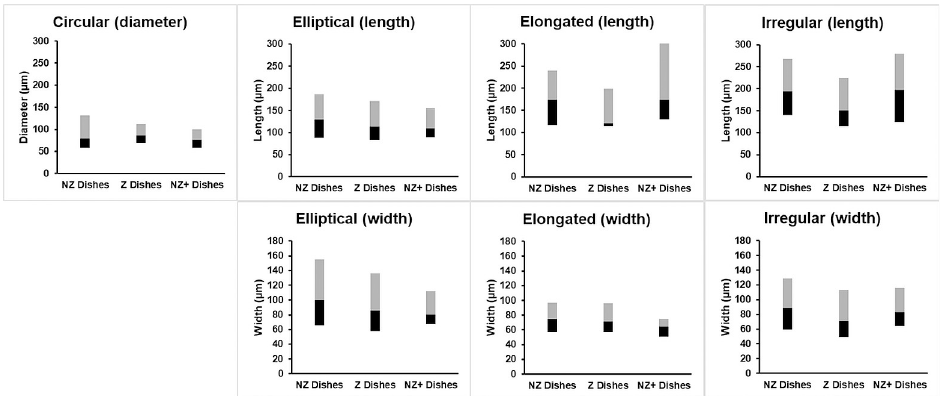
Fig 5. Morphological measurements of 3-D endometrial cell structures. Diameter, lengths, and widths of structures across all observed shapes and treatment groups after two weeks of culture (Median with IQR). The black bar represents quartile 1 (25 th percentile) to the median (50 th percentile), and the gray bar represents the median to quartile 3 (75 th percentile). Number of replicates for each treatment group are listed under each plot. Matching lowercase letters indicate the absence of statistical difference within each category (P >